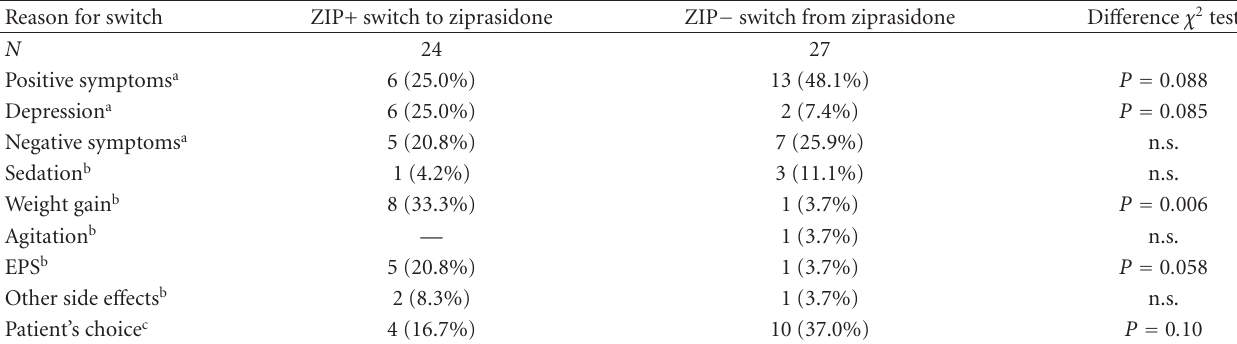
Table 3: Switching to or from ziprasidone-reasons for switch of